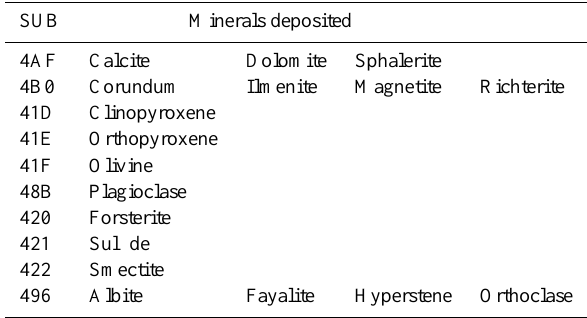
Table 1. Layout of minerals on substrates. In particular we use substrate 496 to validate classification of four minerals and back-